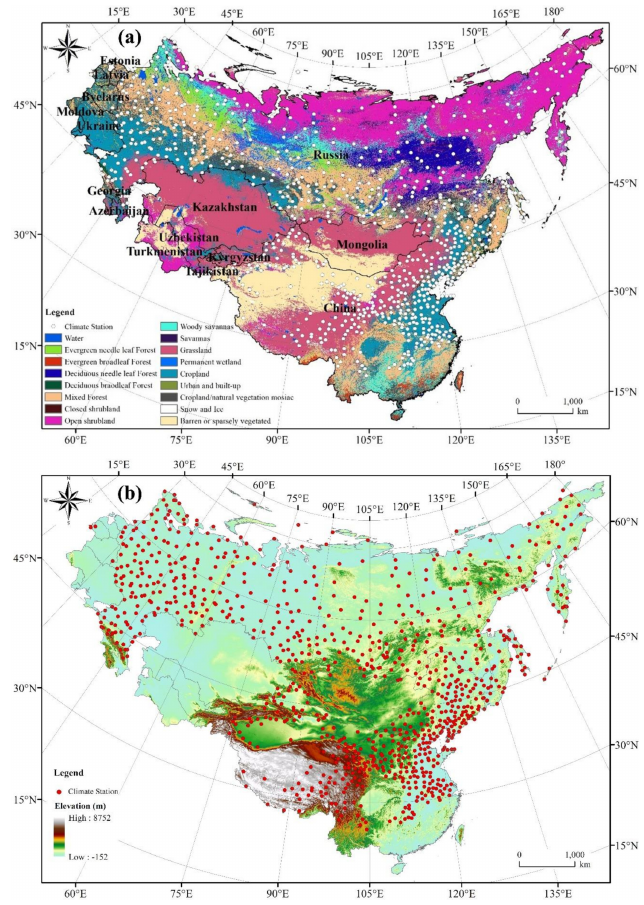
Figure 1. Location and distribution of ground observation sites across the study area: ( a ) MODIS land cover types (MCD12Q1), and ( b ) Shuttle Radar Topography Mission (SRTM) digital elevation